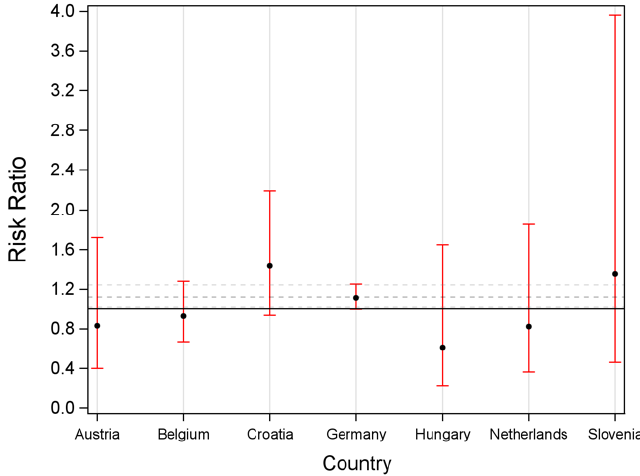
Figure 3. Risk ratio for having died while on the waiting list depending on sex by country.